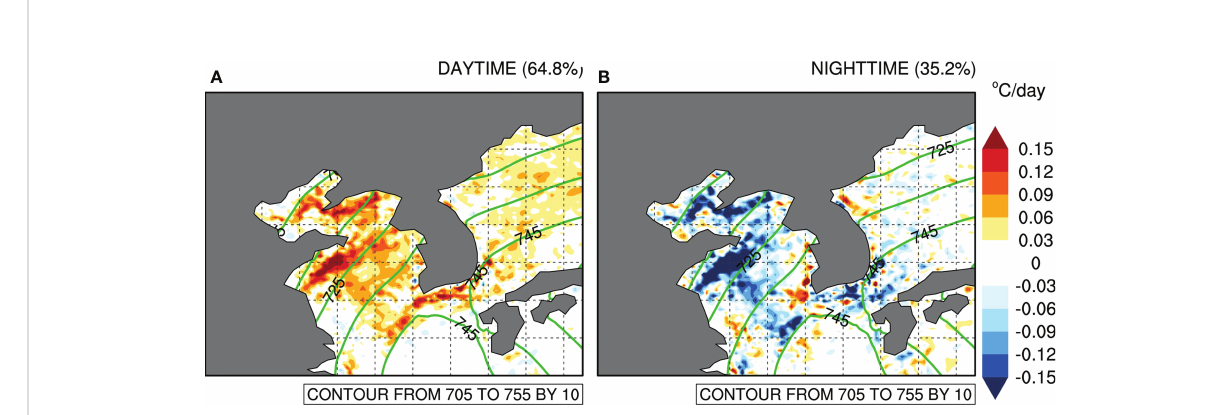
FIGURE 8 Horizontal distribution of the differences in sea surface temperature (SST) warming rates between the CPL_down and CPL_nodown models for the 1994 case during the daytime (A) and nighttime (B) . Positive shading means the heating rate in the CPL_down model was higher than that in the CPL_nodown simulation. Green lines denote the time-averaged geopotential height at 925 hPa.